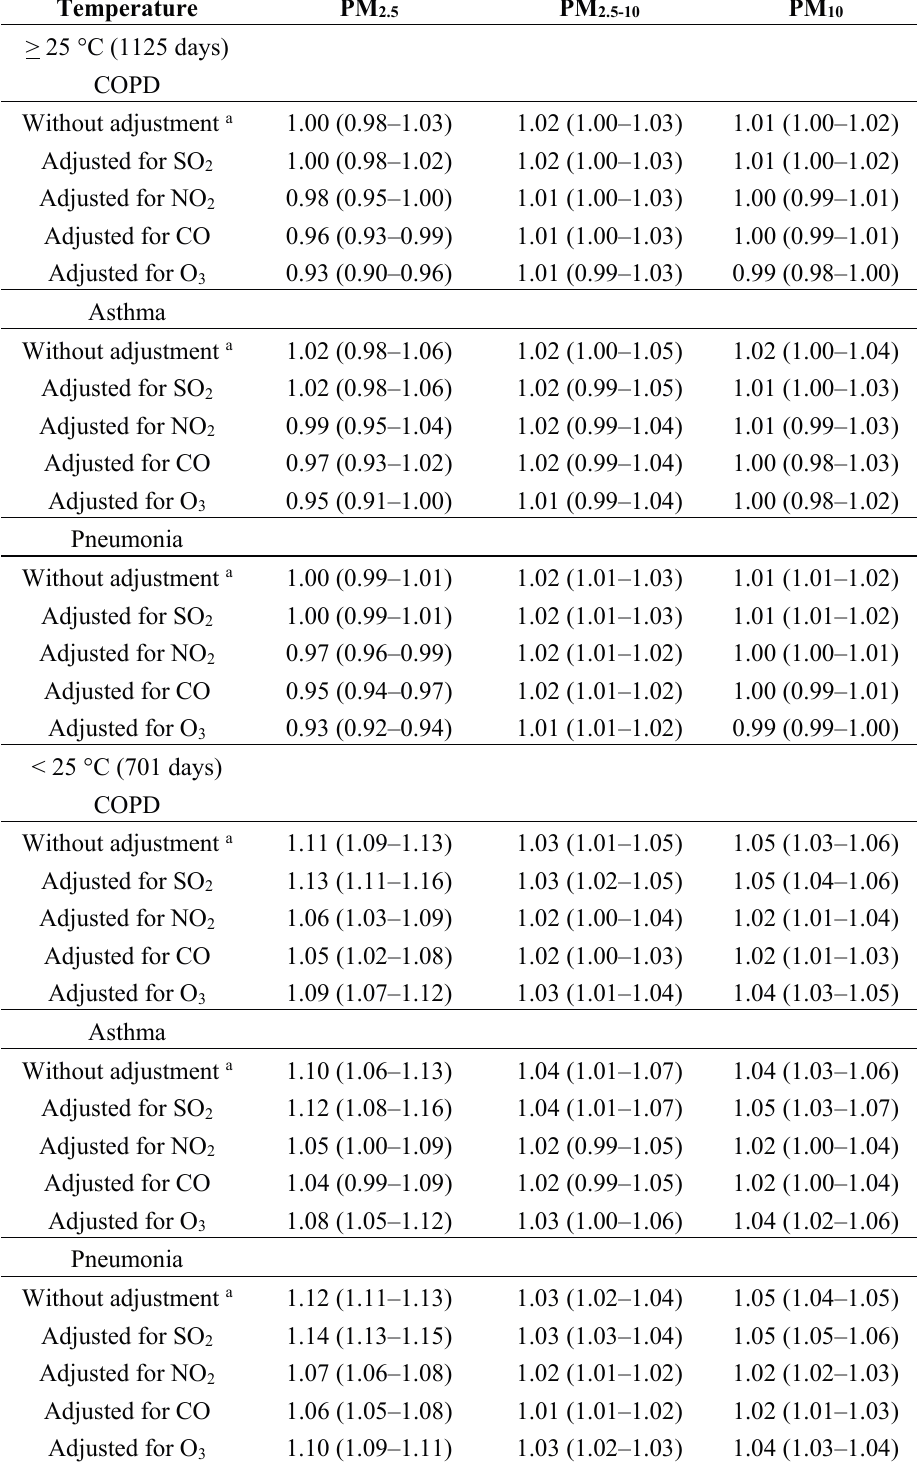
Table 3. Percent increase (95% CI) of hospital admissions for respiratory diseases associated with a 10 μ g/m 3 increase of particulate matter in Kaohsiung, Taiwan,